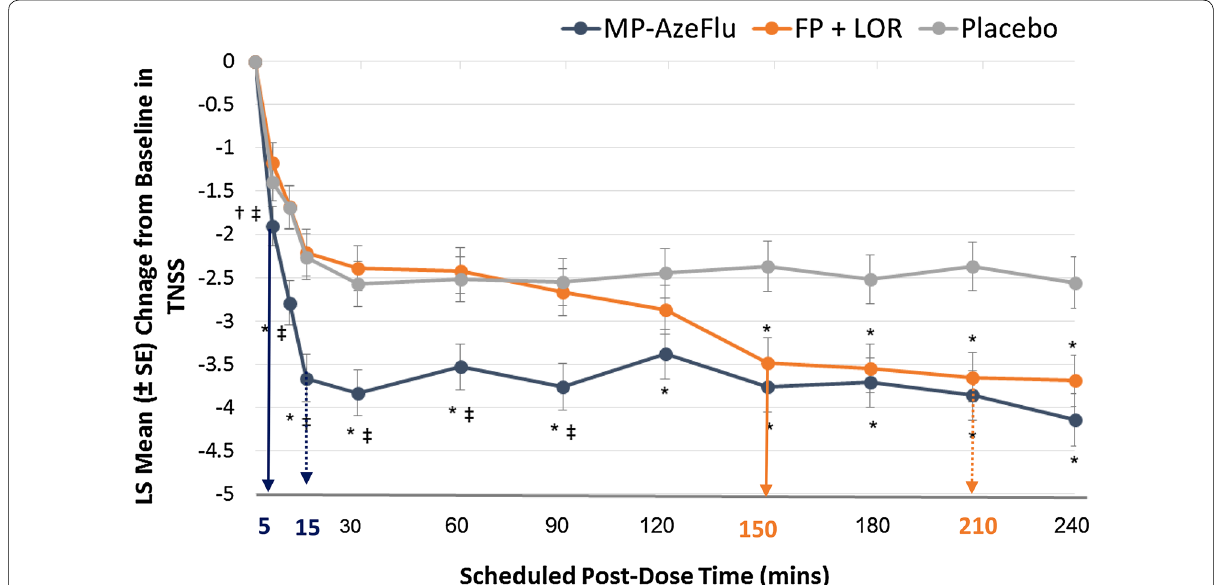
Fig. 2 Effect of MP-AzeFlu, FP LOR and placebo on nasal symptoms. Data are presented as mean change from baseline in total nasal symptom + score (TNSS) assessed over a period of 4 h following exposure to ragweed pollen in an allergen exposure chamber. Arrow: onset of action; dotted arrow: onset to clinically relevant effect compared to placebo (i.e. 1.17 change in TNSS). MP-AzeFlu (MP-azelastine/fluticasone propionate; Dymista ® ; 1 spray/nostril; 138 μg/50 μg); FP (fluticasone propionate; Flonase ® ; 1 spray/nostril; 50 μg) LOR (Loratadine; Claritin ® ; 10 mg). LS: least squares; SE: + standard error. *p 0.005 vs placebo; † p 0.038 vs placebo; ‡ p 0.003 vs FP LOR. Modified from Bousquet et al. 2017 ≤ = ≤ +